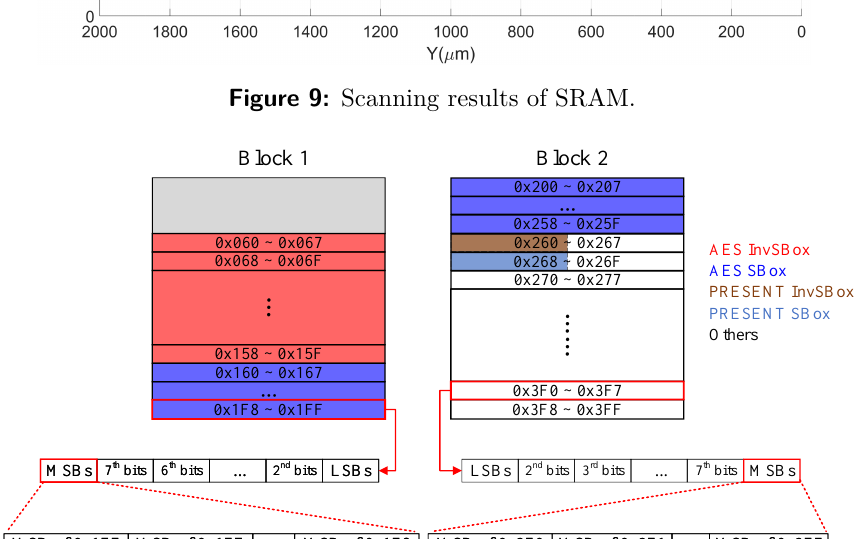
Figure 10: Address mapping of SRAM. Addresses of SBoxes and InvSBoxes are colored. One row of each SRAM block is zoomed to detail bit